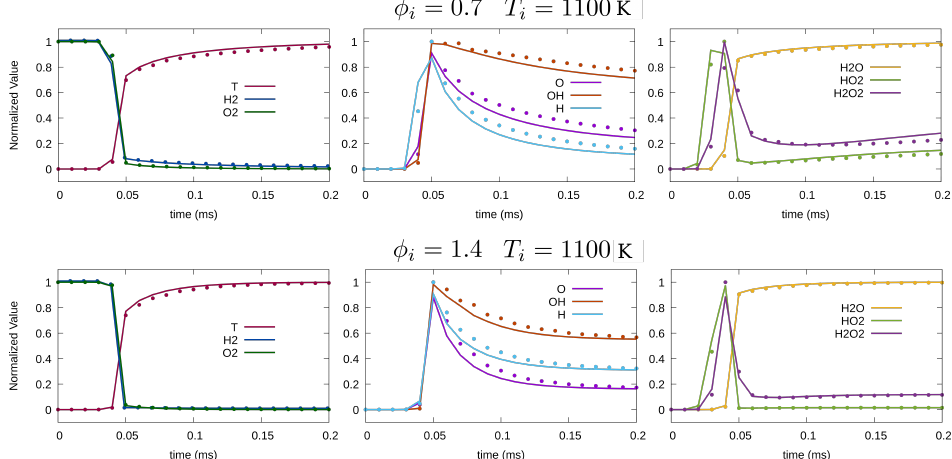
Figure 4. Temporal variation of normalized temperature and species concentration for T i = 1100 K, φ i = 0.7 ( top ), and φ i = 1.4 ( bottom ). Solid line and symbols represent the OpenFOAM and LIT solution,